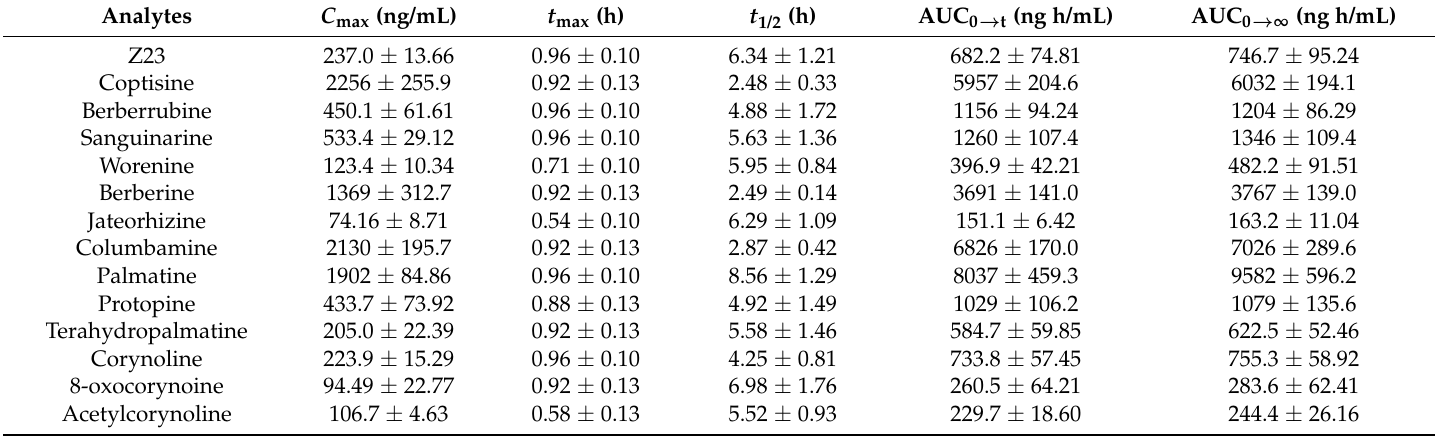
Table 5. Pharmacokinetic parameters of the fourteen constituents in beagles after oral administration of C. bugeana (mean ± SD, n =